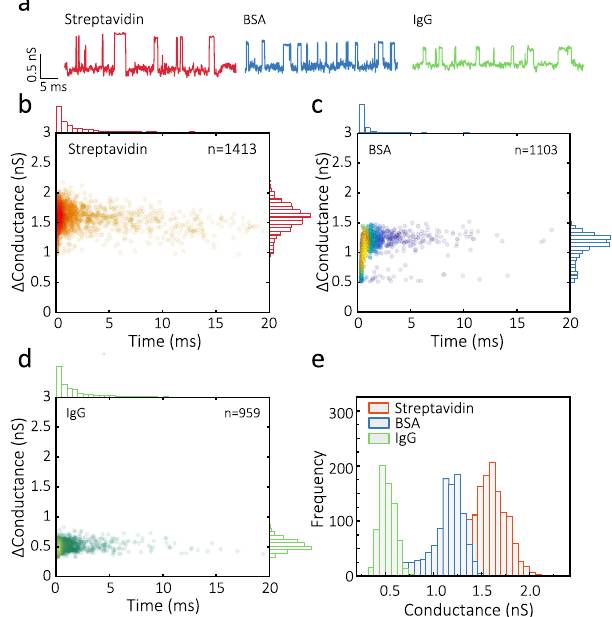
Fig. 5 QMT detection of streptavidin, BSA and IgG. a Representative conductance – time traces for a solution consisting of 10 nM of proteins using a tunnelling junction with a gap width of ~1.8 nm and an applied bias of 100 mV. b – d Scatter plots of change in conductance versus duration for transients associated with streptavidin, BSA, and IgG. e Normalised histogram of the change in conductance for the three proteins highlighting a clear difference in amplitude of the